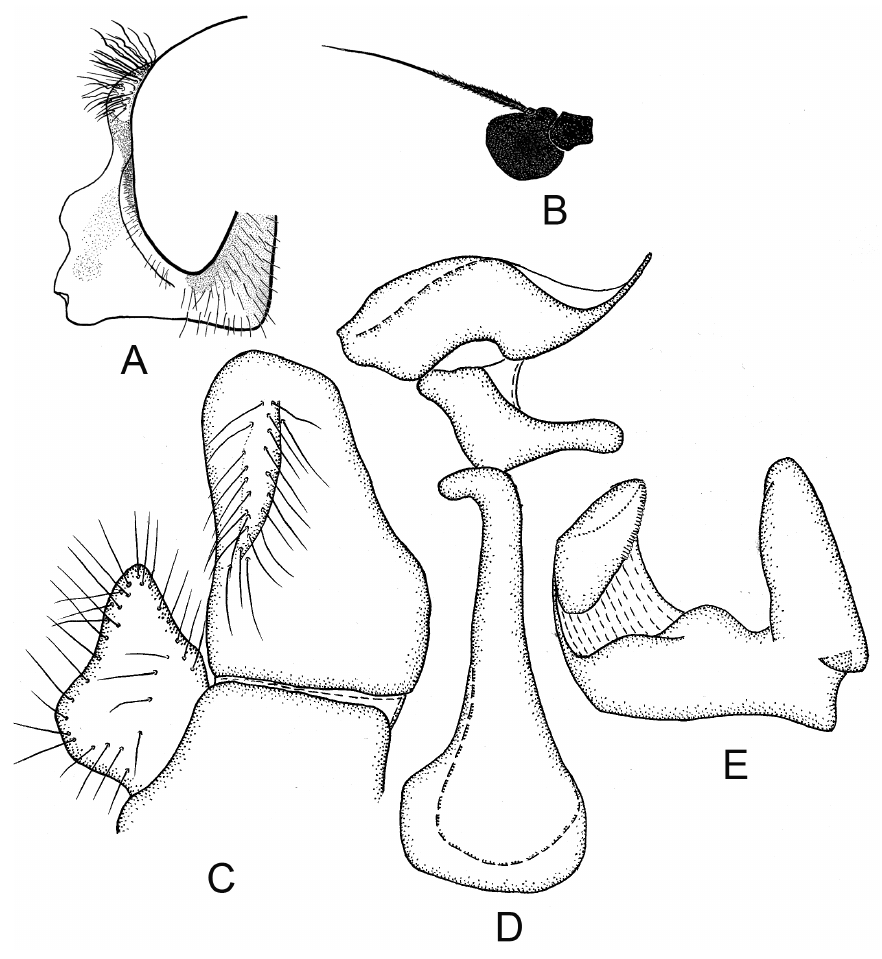
Figure 2. Cheilosia armeniaca Stackelberg, male. A Head, lateral view B Antenna, lateral view C–E male genitalia, lateral, from left to right: C Cercus+surstylus D Aedeagal complex E Superior lobe. Cheilosia caerulescens caerulescens (Meigen) Figs 3,